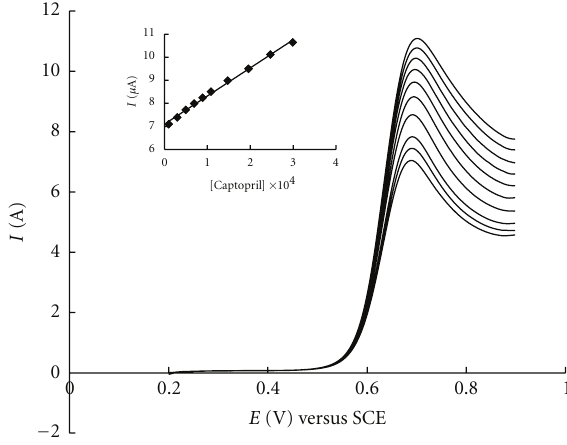
Figure 6: Linear sweep voltammograms for di ff erent concentra- tions of CAP; from bottom to top: 0.010, 0.030, 0.050, 0.070, 0.089, 0.110, 0.150, 0.200, 0.250, 0.300 mM. [CPZ] = 0.5mM; pH = 4; scan rate of 50 mVs − 1